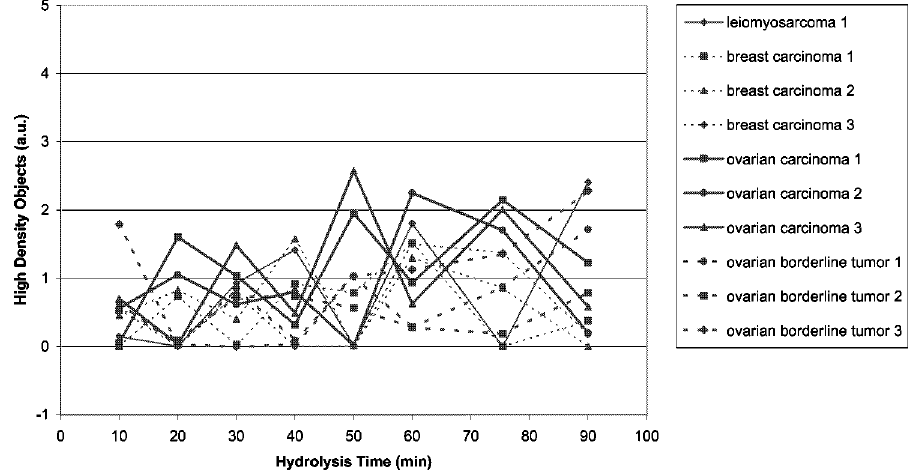
Fig. 2. Hydrolysis profiles based on “high density objects” in breast carcinoma, ovarian serous adenocarcinoma, ovarian serous tumor of border- line malignancy and leiomyosarcoma.